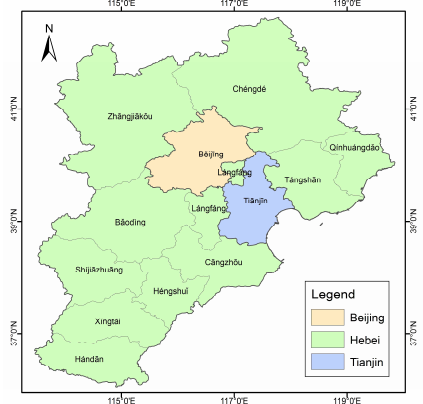
Figure 1. Geographic location and administrative divisions of BTH region